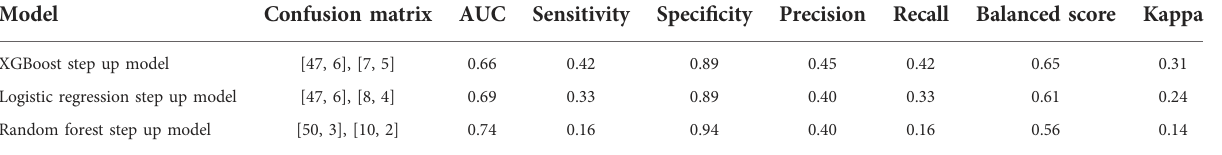
TABLE 6 Step up in WHO-5 level (e.g. regular to low = Step up) with a machine learning